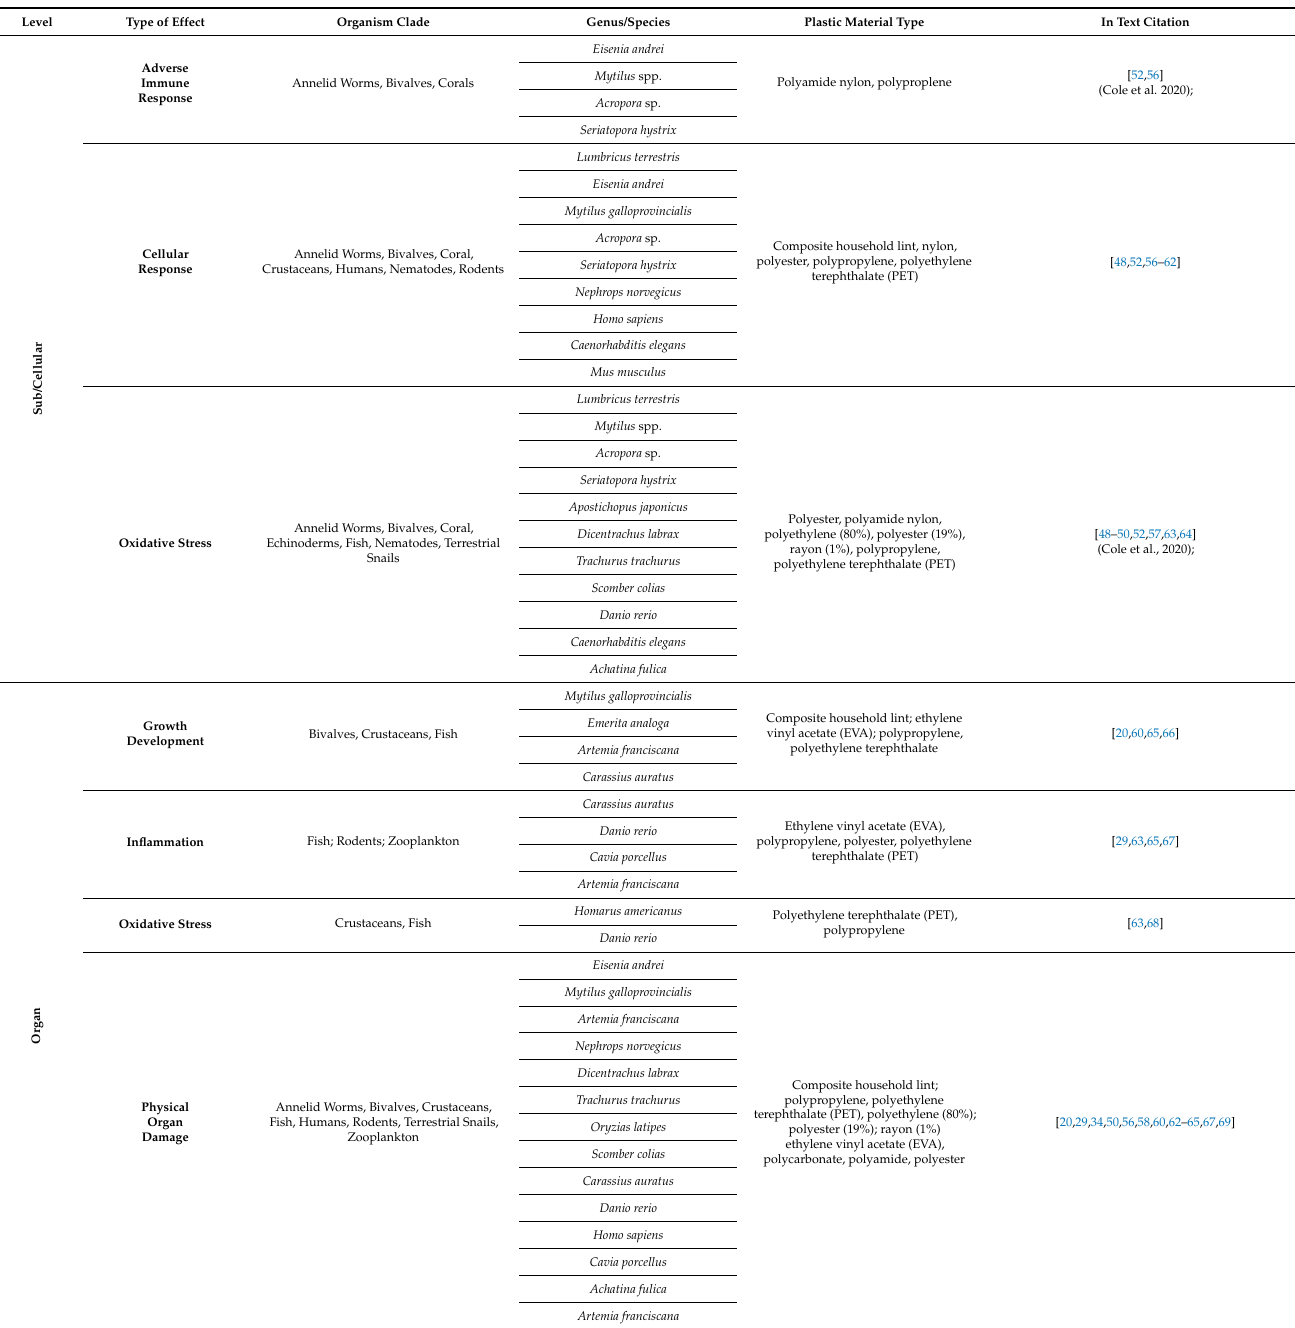
Table 1. Ecological and biological effects of fibers on organisms by species and material type. Modified from Granek et al.,